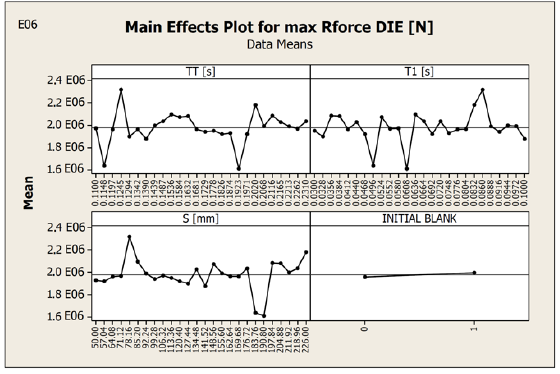
Figure 18. MEP for min thick % output.